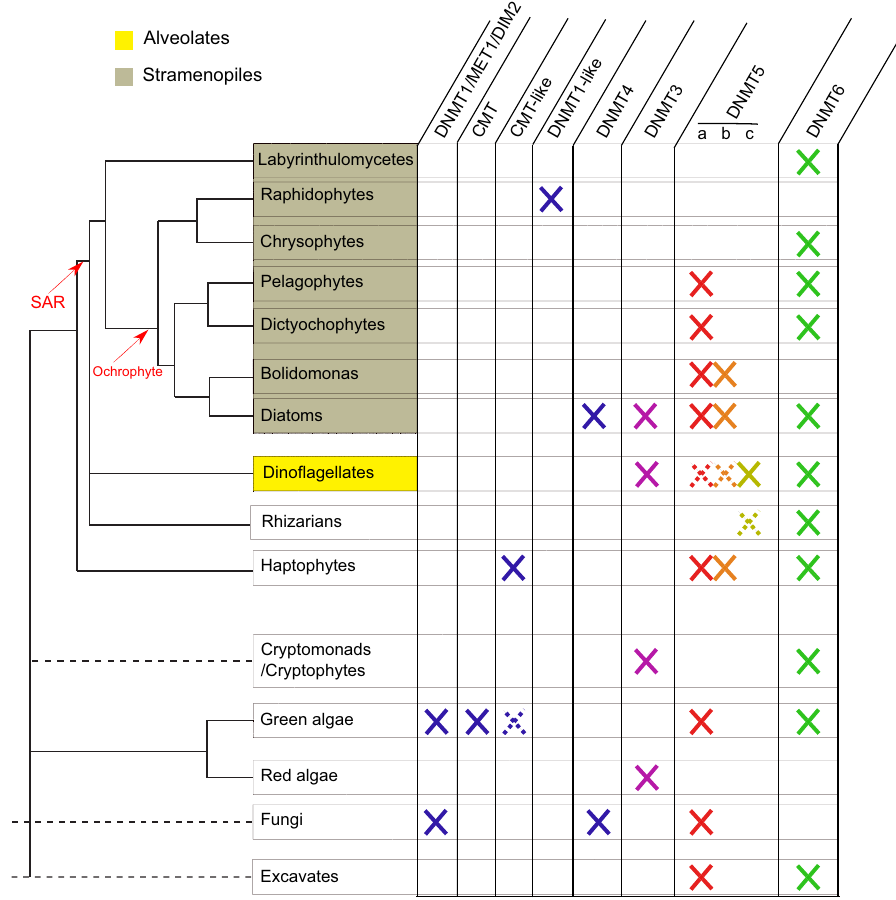
Fig. 2 Summary of DNMT family lineages found in microeukaryotes. Full crosses report the presence of a given gene family within lineages. Dashed lines and crosses indicate the uncertainty in the eukaryotic phylogeny as well as low support presence of a given DNMT family within lineages. Fungi that share DNMT families with other eukaryotes presented in this study are shown for comparison purposes. SAR: Stramenopile Alveolate Rhizaria lineage. Ochrophyte are secondary endosymbiont, photosynthetic lineages of